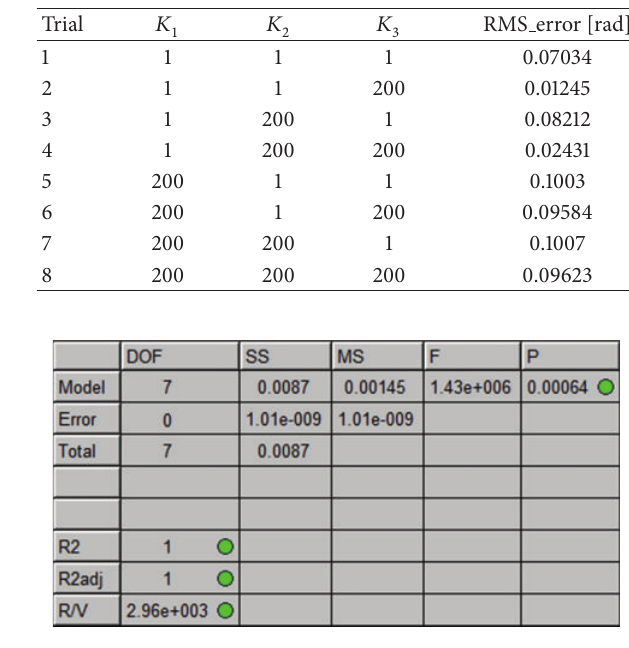
Figure 8: The fit table for the regression